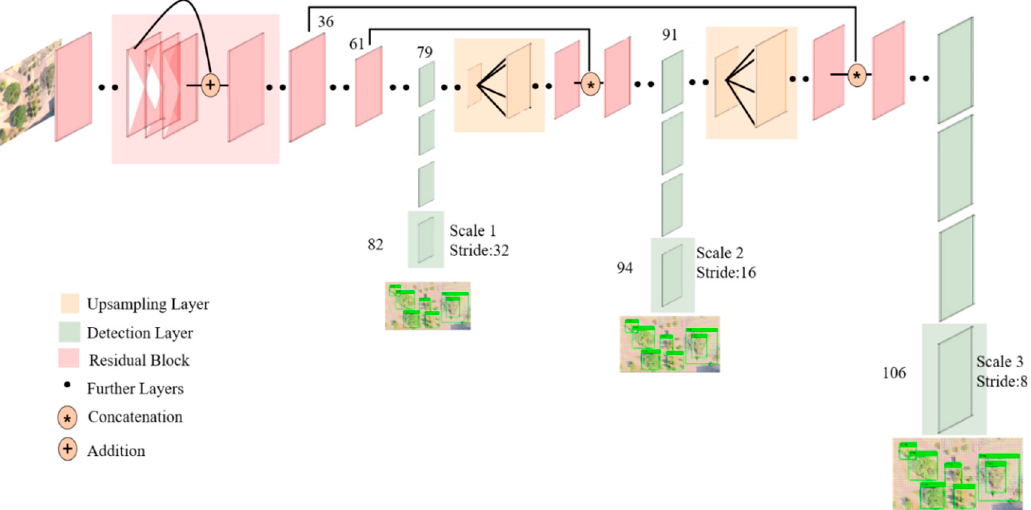
Figure 10. YOLOv3 architecture.